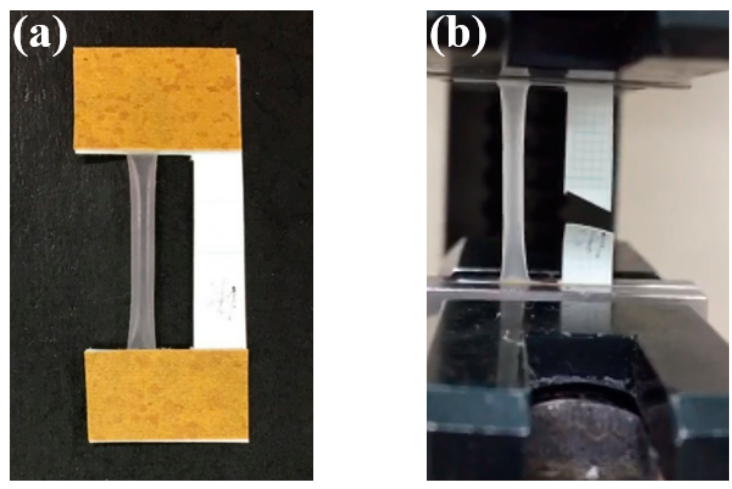
Figure 2. The collagen tube fixed on the paper frame ( a ) and that clamped by the tensile tester ( b